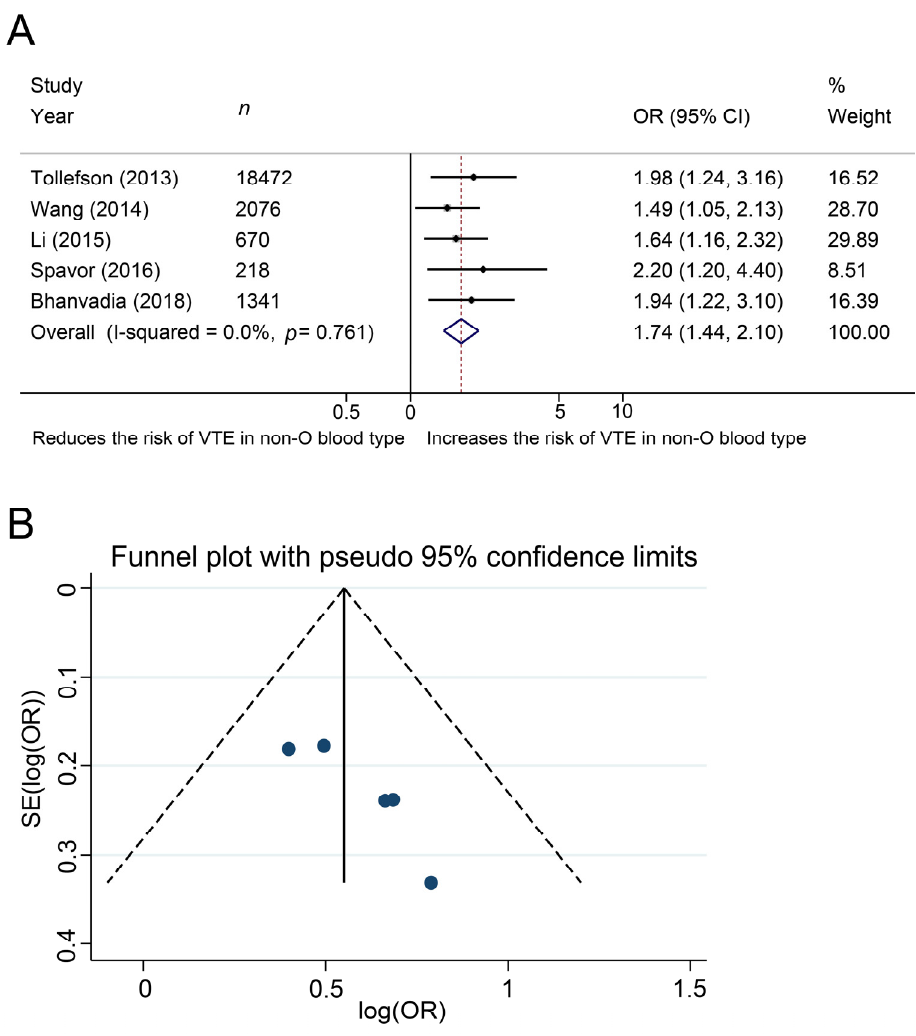
Figure 2. Forest ( A ) and funnel ( B ) plot showing the association of ABO blood type with development of venous thromboembolism among patients with cancer.